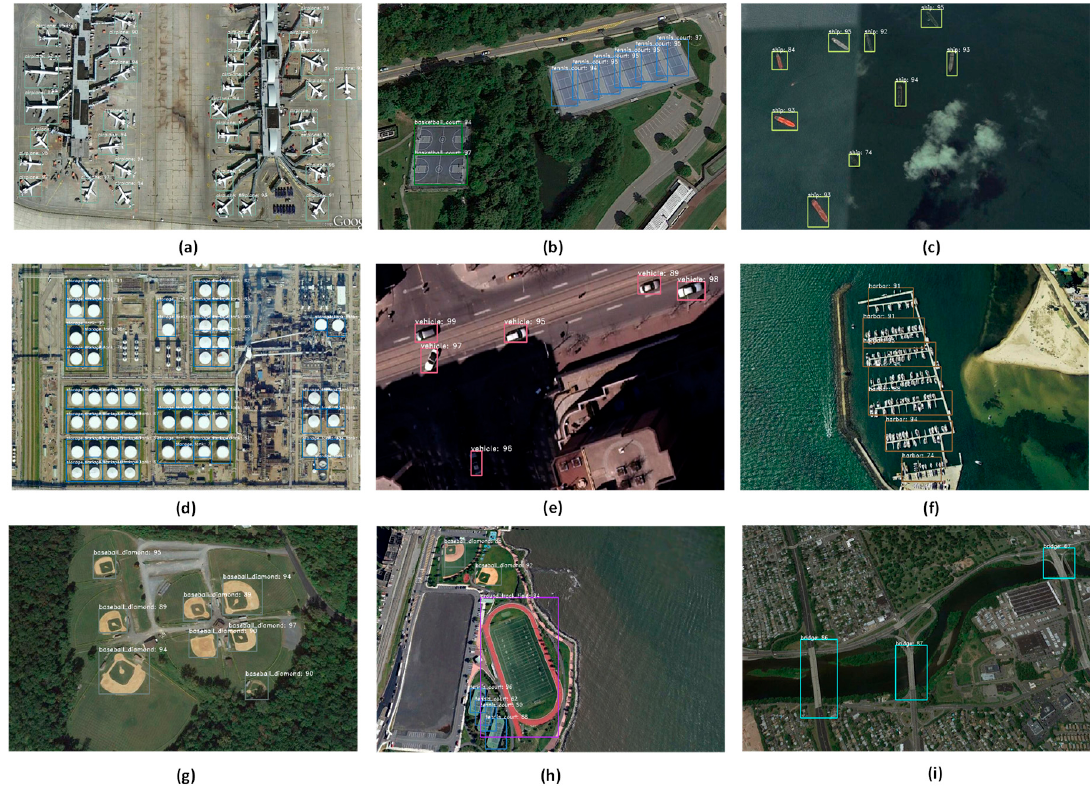
Figure 8. Visualization of some object detection results of all the categories by proposed method in the NWPU VHR-10 dataset. ( a ) airplanes. ( b ) tennis courts and basketball courts. ( c ) ships. ( d ) storage tanks. ( e ) vehicles. ( f ) harbors. ( g ) baseball diamonds. ( h ) tennis courts, baseball diamonds and the ground tack field. ( i ) brigdes.